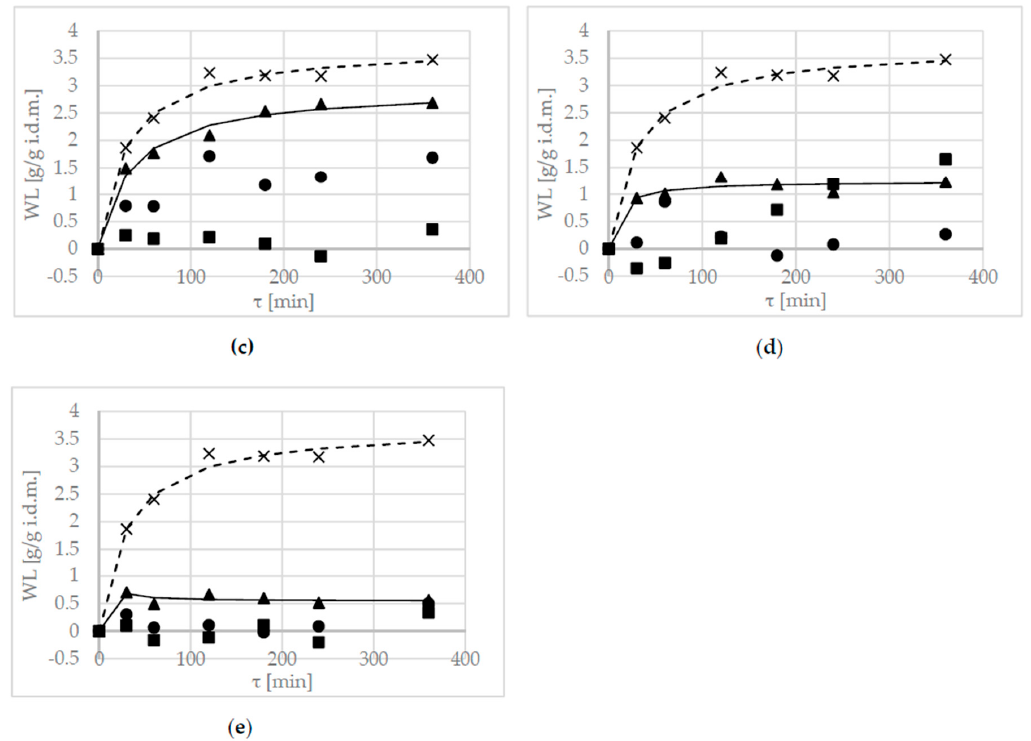
Figure 1. Water loss (WL) kinetics at several concentrations, (20 ( ■ ), 30 ( ● ), 40 ( ▲ ) and 50 (×) g/100g) at 40 °C, in different solutions: ( a ) erythritol, ( b ) xylitol, ( c ) maltitol, ( d ) inulin, ( e ) oligofructose. Lines are the Peleg’s model. The dotted line is the kinetic reference (sucrose).